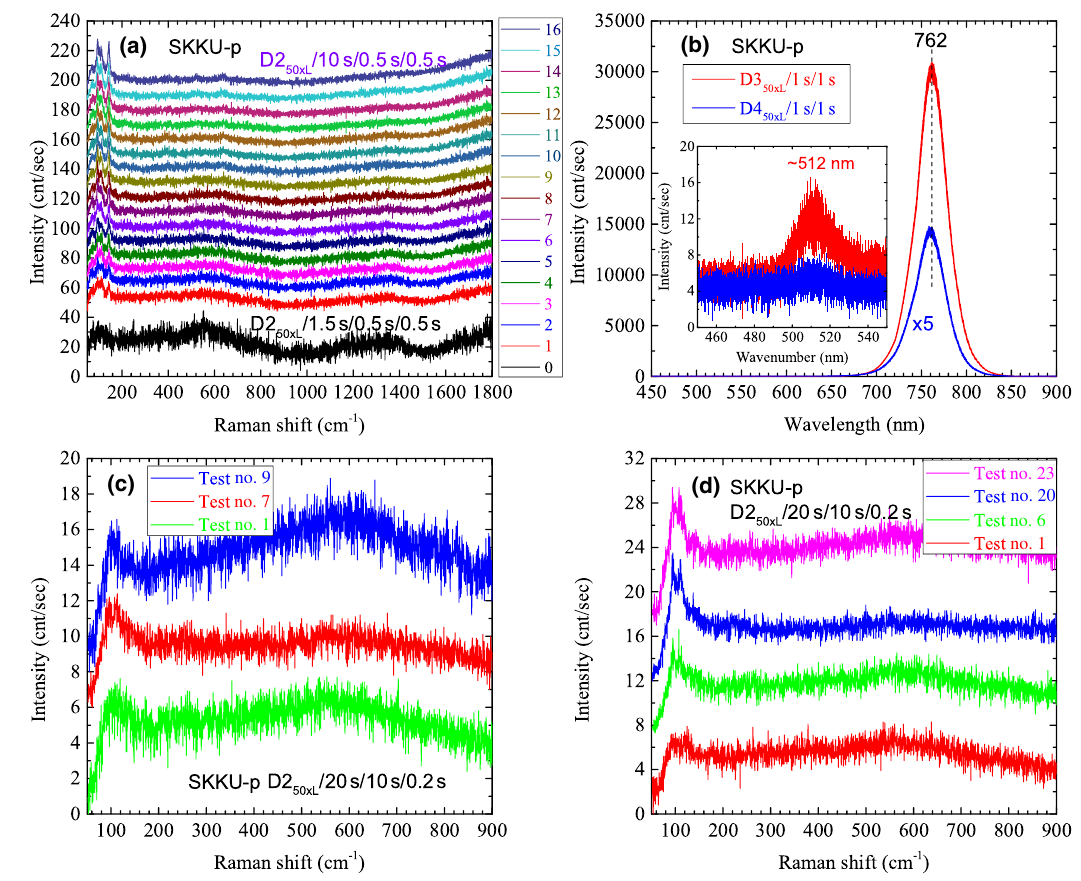
FIG. 5. Effects of multiple consecutive Raman measurements in SKKU-p samples under D2 excitation. (a) Sixteen consecutive measurements with ∼ 20 s in between. (b) PL spectra measured after the Raman measurements shown in (a). (c) Eight consecutive measurements with ∼ 20 s in between, then waited for 10 min before the last one (no. 9). (d) Twenty-two consecutive measurements with ∼ 20 s in between, then waited for 10 min before the last one (no.